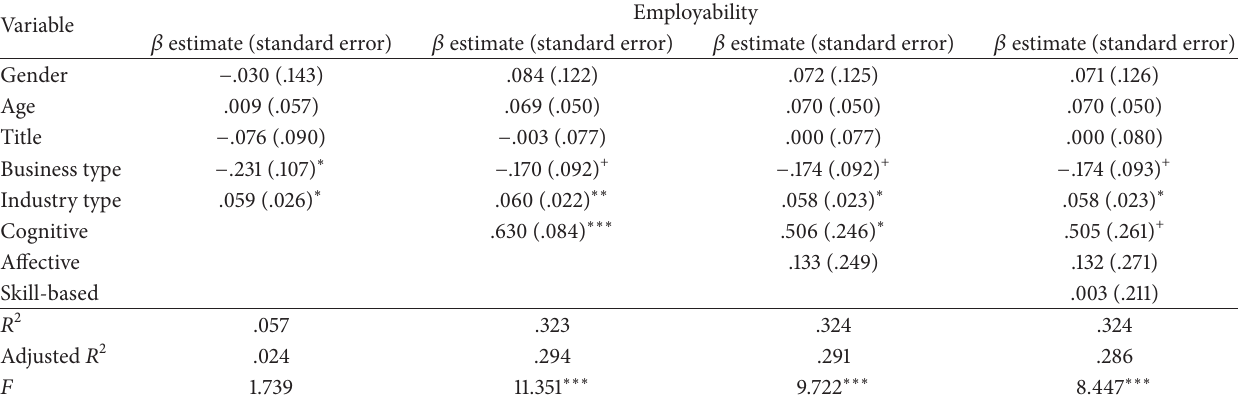
Table 9: Multiple regression analysis—three-domain curriculum on employability (industry